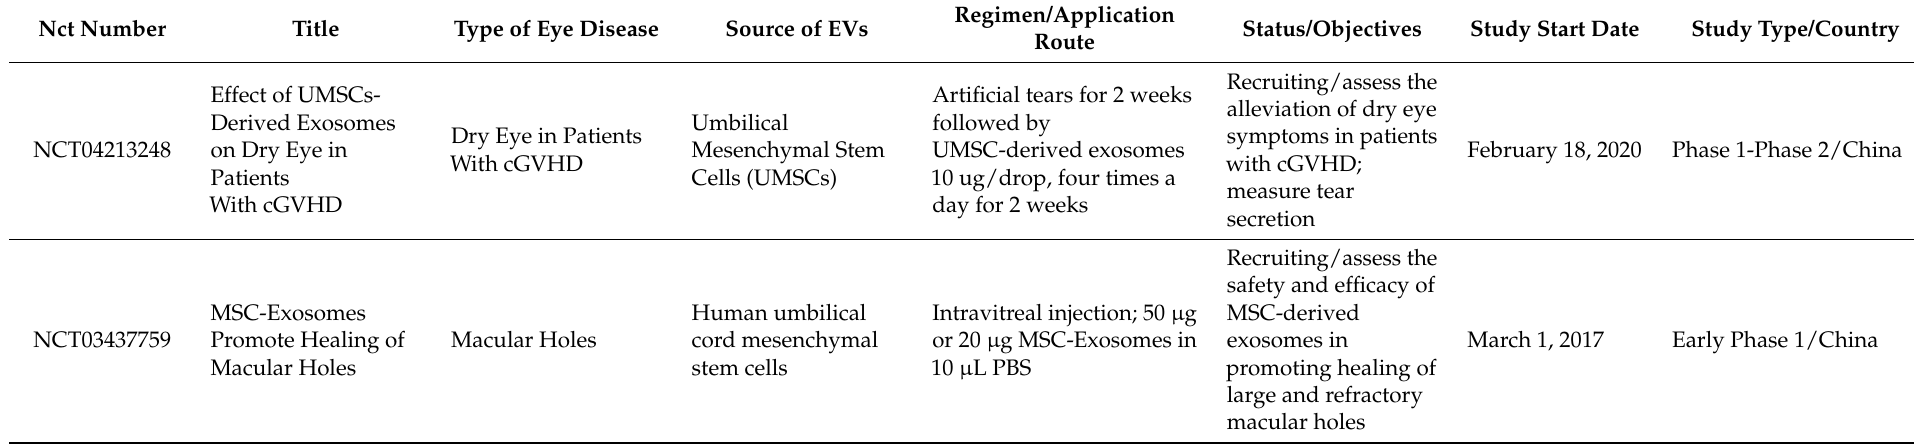
Table 2. Current clinical trials employing EVs in ocular diseases [53]; MSC: Mesenchymal stem cells; cGVHD: corneal Graft versus Host